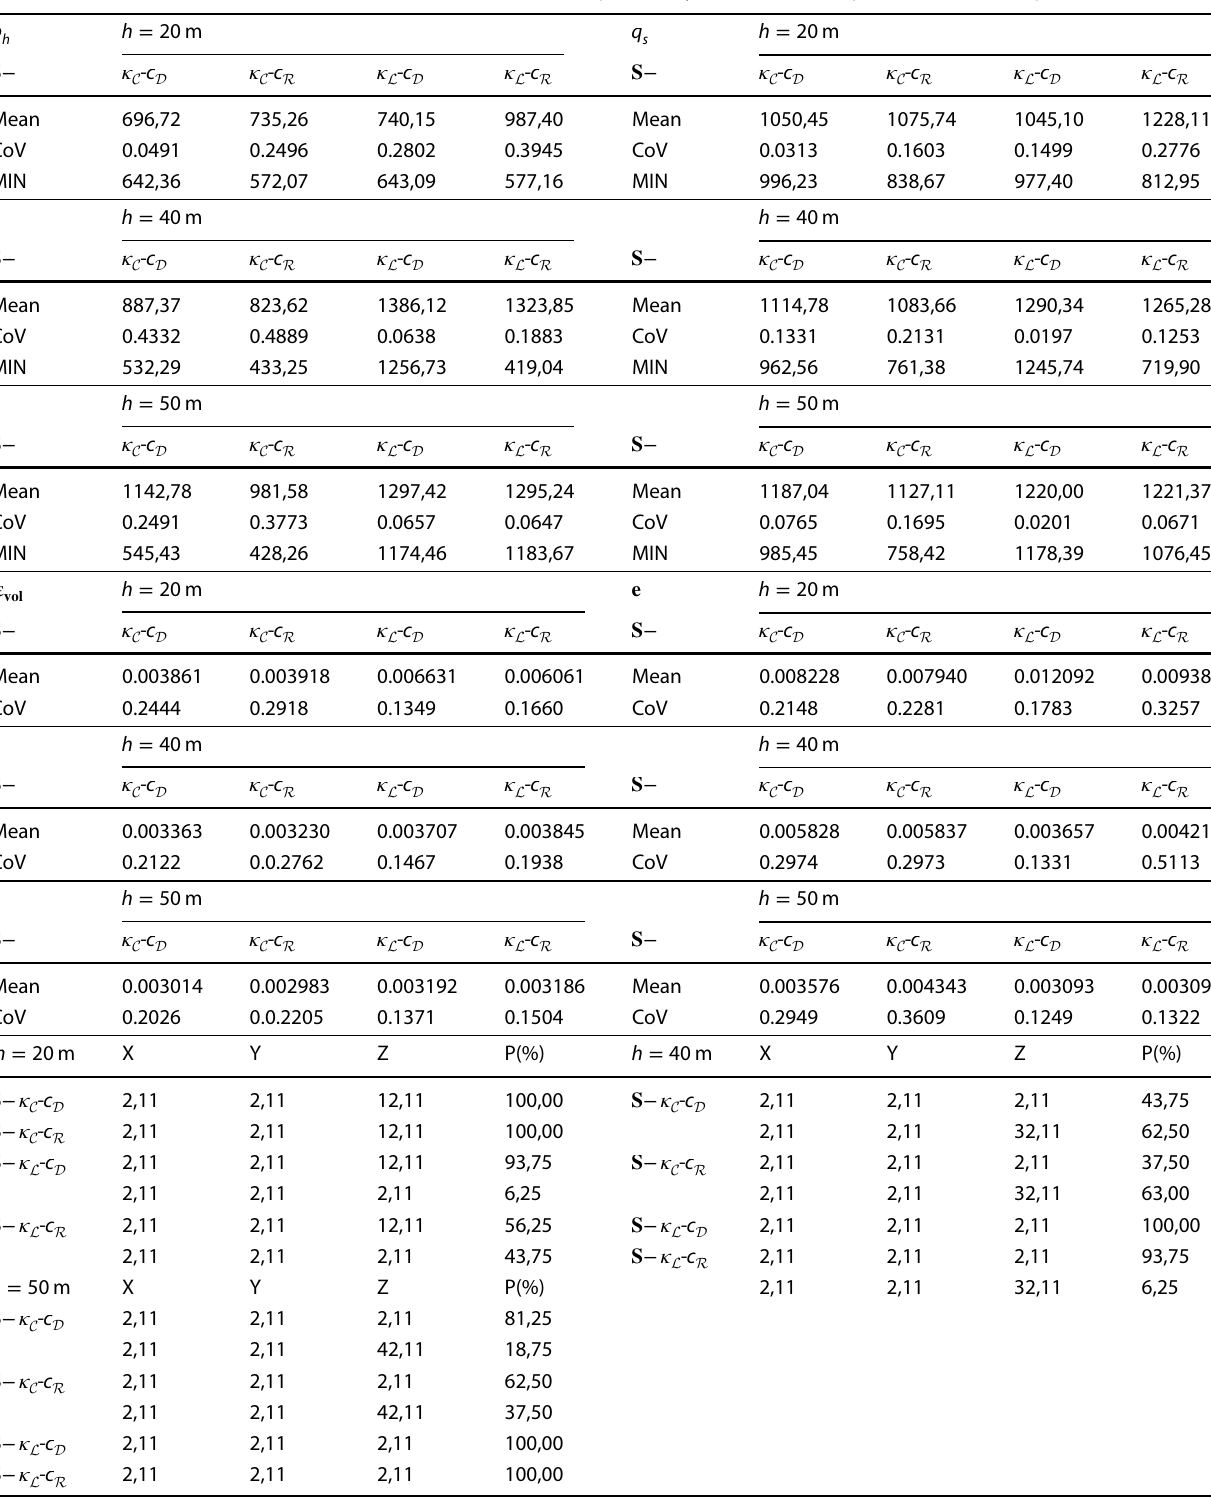
Table 9 Monte Carlo results for the stresses (KPa), the strains and the probability of the first Gauss point failure for non-porous